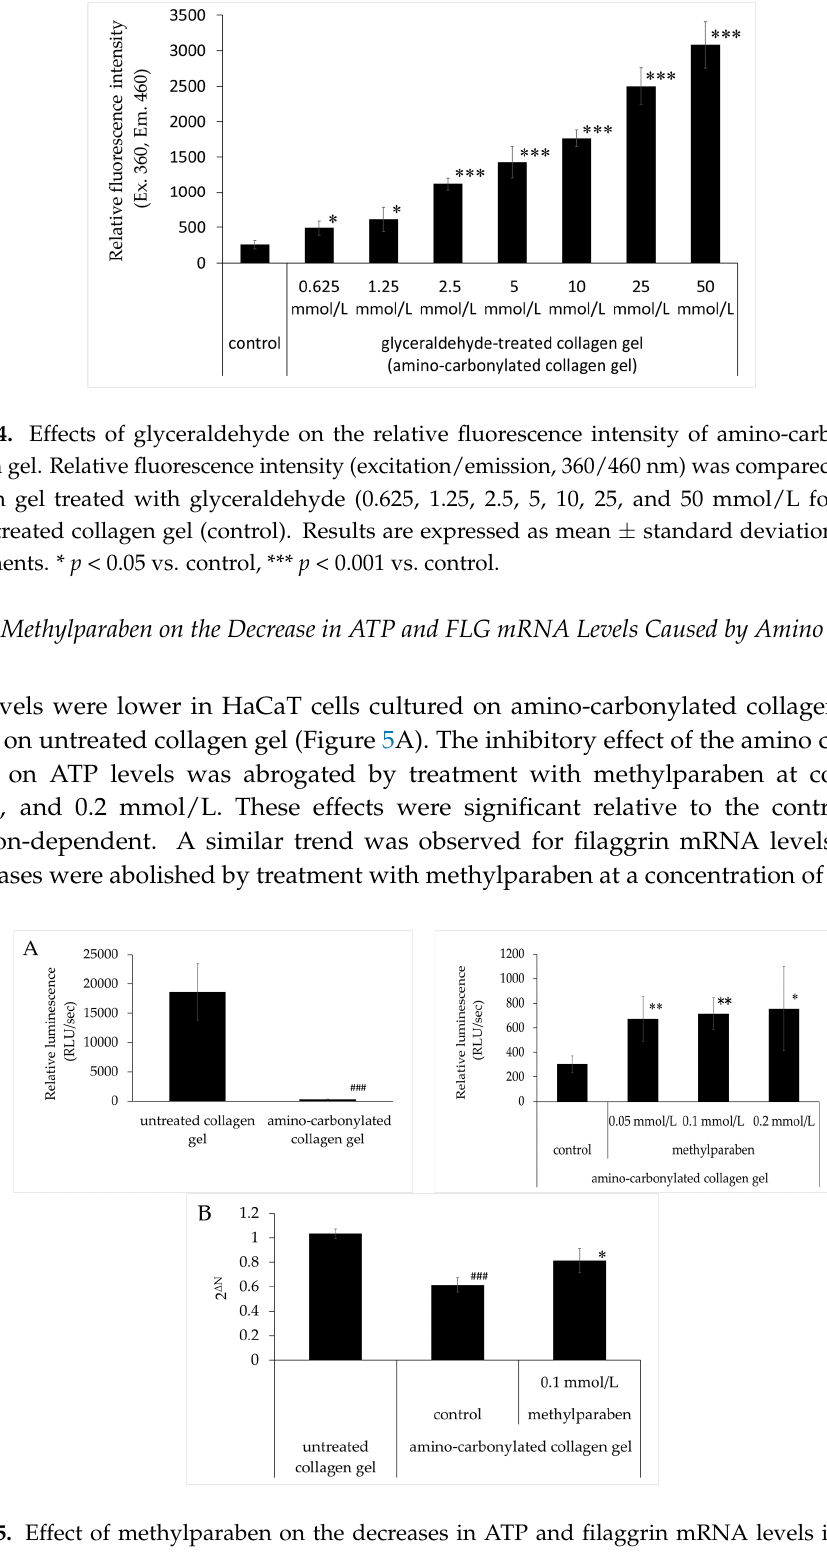
Figure 5. Effect of methylparaben on the decreases in ATP and filaggrin mRNA levels in HaCaT cultured on amino-carbonylated collagen gel. ( A ) ATP levels in amino-carbonylated collagen gel in the left figure and control in right figure are the same data; ( B ) Filaggrin mRNA. Results are expressed as mean ± standard deviation of three experiments. ### p < 0.001 vs. untreated collagen gel; * p < 0.05, ** p < 0.01 vs. control on amino-carbonylated collagen